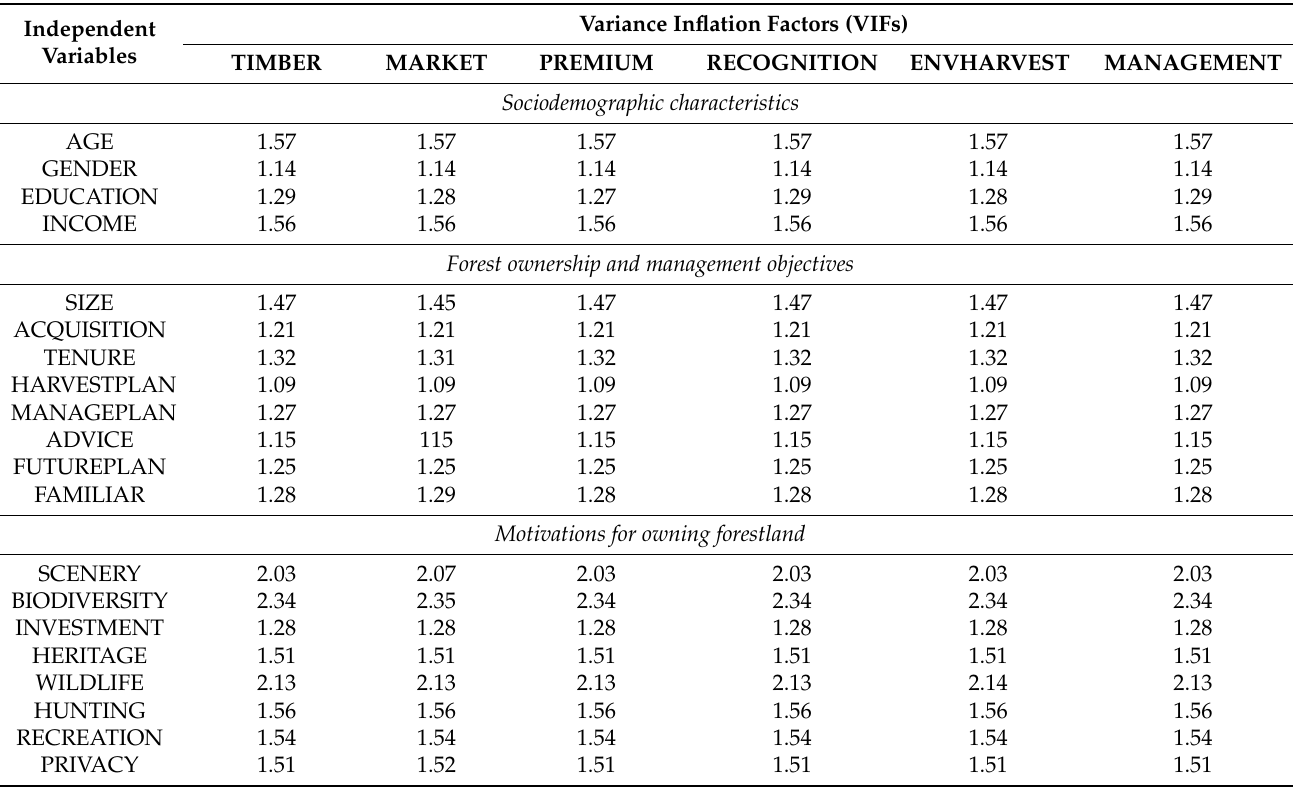
Table 3. Variance inflation factors (VIFs) among independent variables for all six regression models.